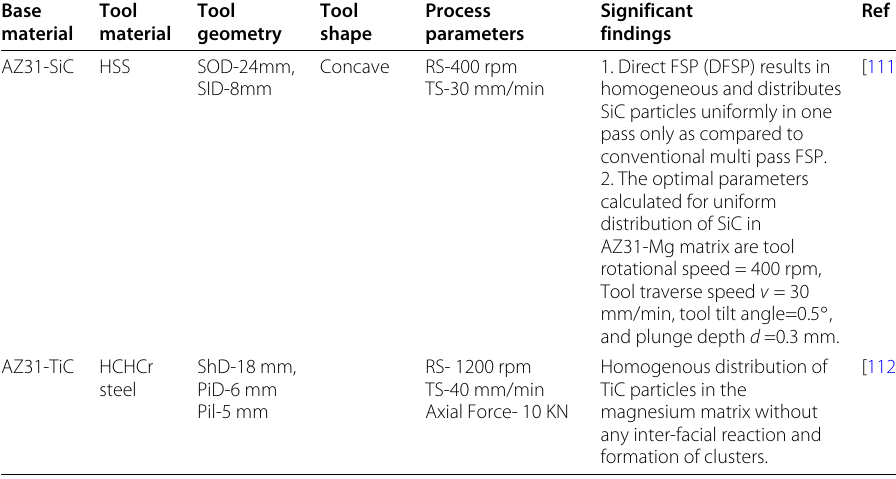
Table 4 Brief summary of Mg-MC surface MMCs by FSP as available in the literature ( Continued )